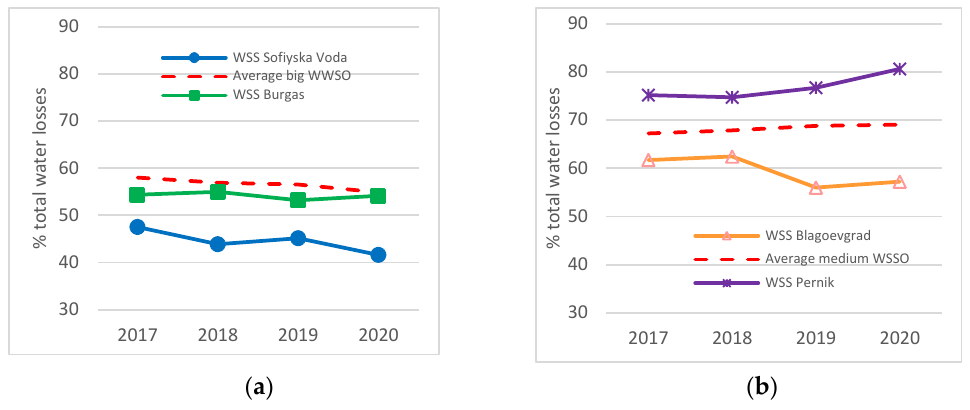
Figure 4. Trends in NRW for ( a ) ViK Blagoevgrad and ViK Pernik, and ( b ) Sofiyska Voda and ViK Burgas.